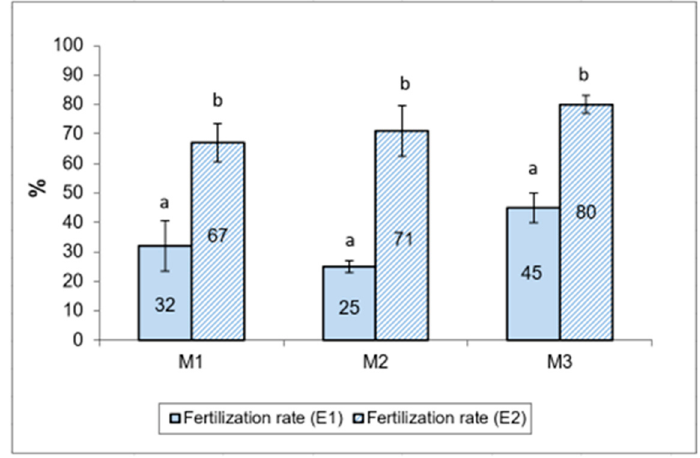
Figure 5. Sterlet eggs fertilization percentage, fertilized by cryopreserved semen of Russian sturgeon using the E1 and E2 extenders. Different letters indicate significant differences ( p ≤ 0.01).